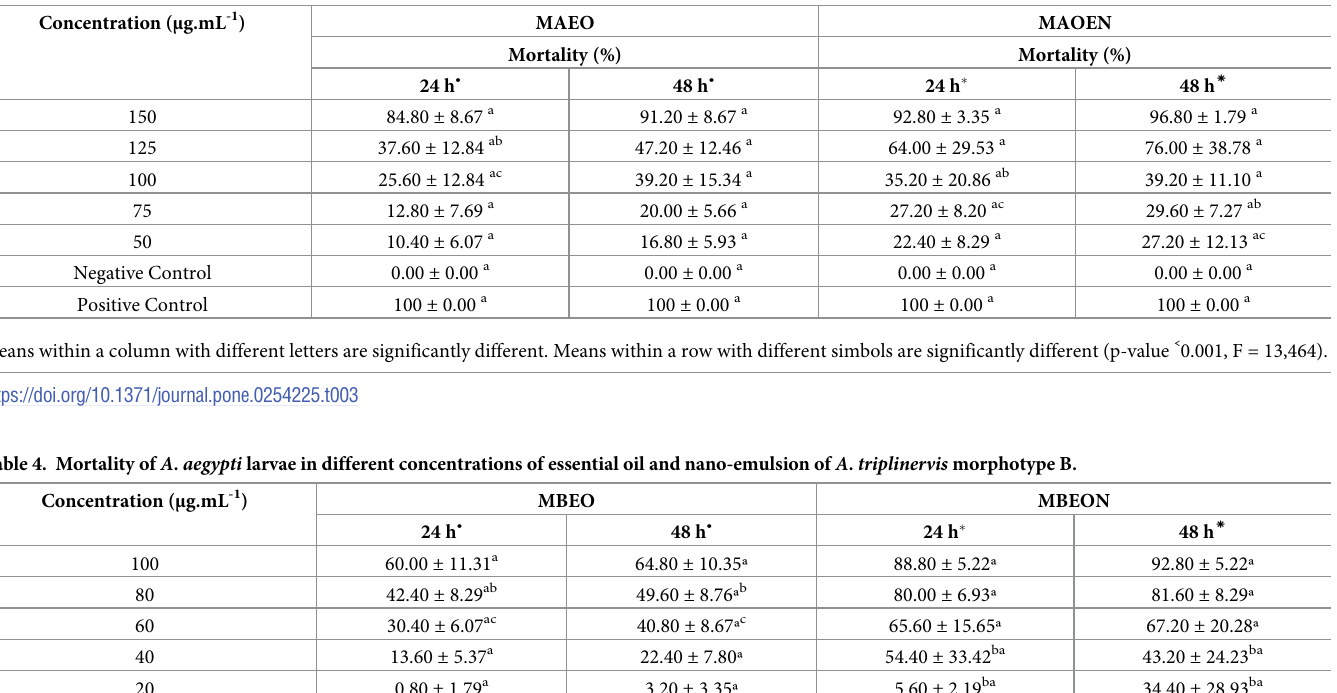
Table 3. Mortality of A . aegypti larvae in different concentrations of essential oil and nano-emulsion of A . triplinervis morphotype A. Concentration ( μ g.mL -1 )